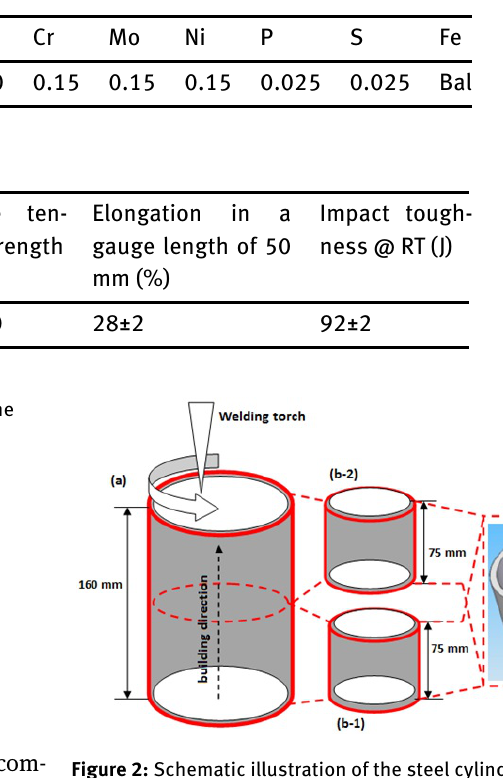
Table 1: Chemical composition (wt%) of filler metal (all weld metal).